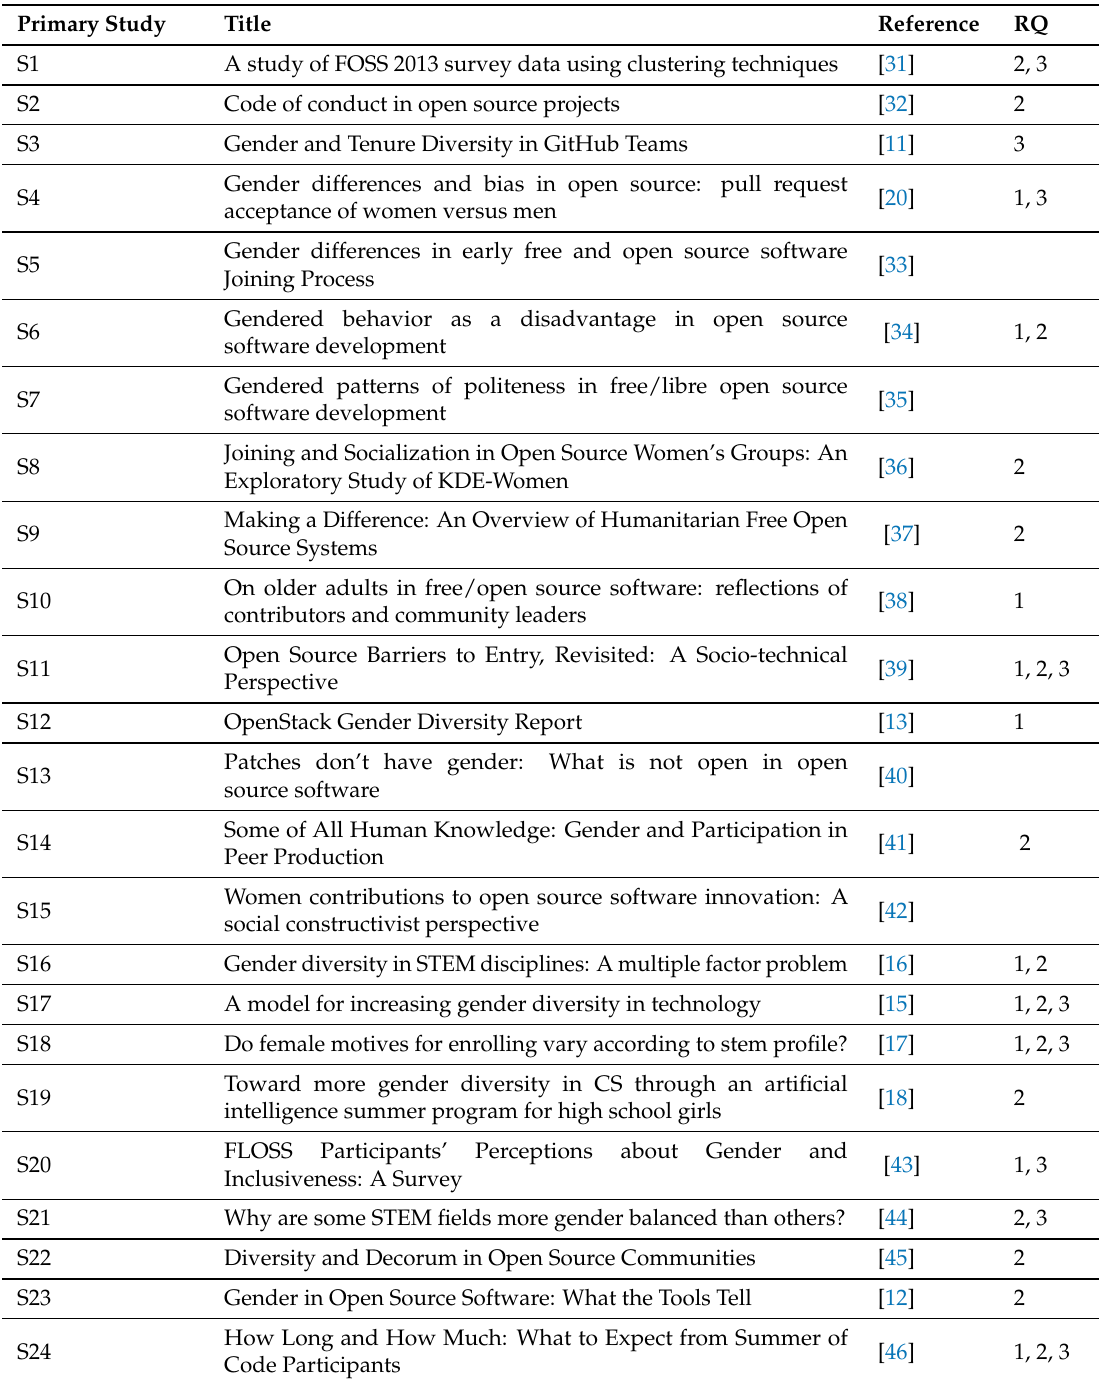
Table 2. Relation of selected